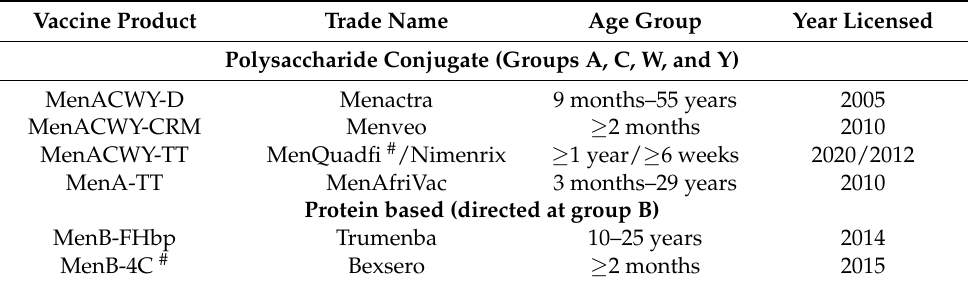
Table 1. Meningococcal protein andpolysaccharide conjugate vaccines *. Vaccine Product Trade